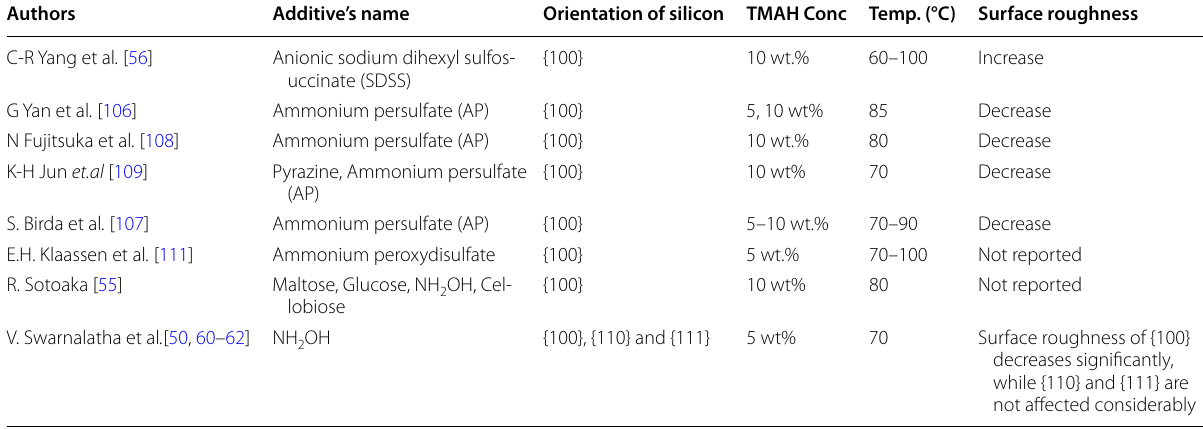
Table 4 The effect of various kinds of additives on etched surface roughness of silicon in TMAH